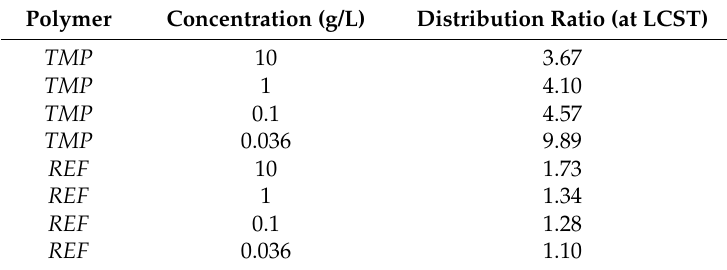
Table 1. Distribution ratios of various concentrations of polymer TMP and REF measured at their respective LCST values. An initial concentration of 100 nM of fluorescein was used for all concentrations of